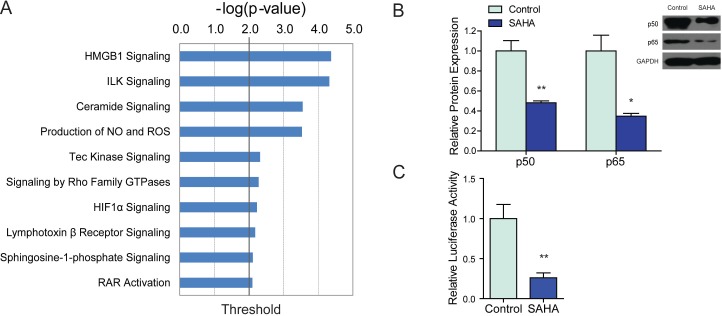
Canonical pathway analysis and further validation.(A) The top 10 canonical pathways of genes down-regulated by 2.5 µM SAHA in LX2 cells as determined by Ingenuity Pathway Analysis. The x axis showed the negative log of p value. (B) The protein expressions of p50 and p65 in 2.5 µM SAHA treated LX2 cells were determined by western blot. GAPDH was used as a loading control. (C) The activity of NF-κB in SAHA treated LX2 cells were detected by a dual luciferase reporter system. NF-κB driven firefly luciferase activity was assayed by a dual luciferase reporter system, renilla luciferase activity served as internal control, the results were expressed as relative luciferase activity. ∗P < 0.05, ∗∗P < 0.01, compared to the control.